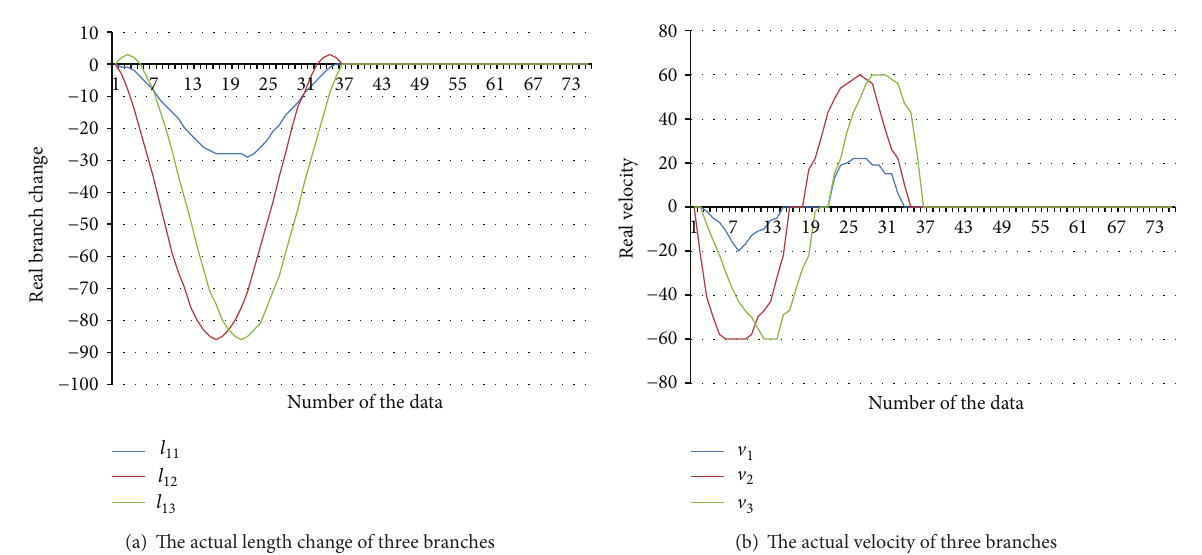
Figure 12: Movement of 2-UPS+UP PM for 5sec.